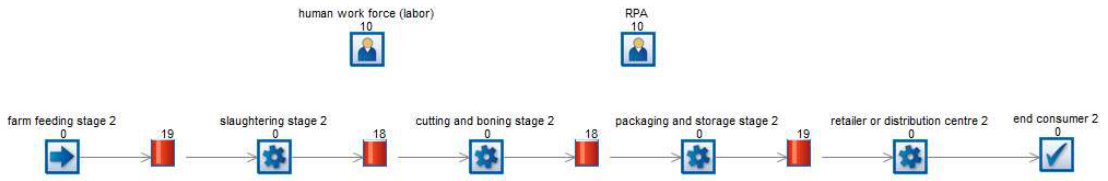
Figure 7. Scenario 2 simulation model of beef supply chain.